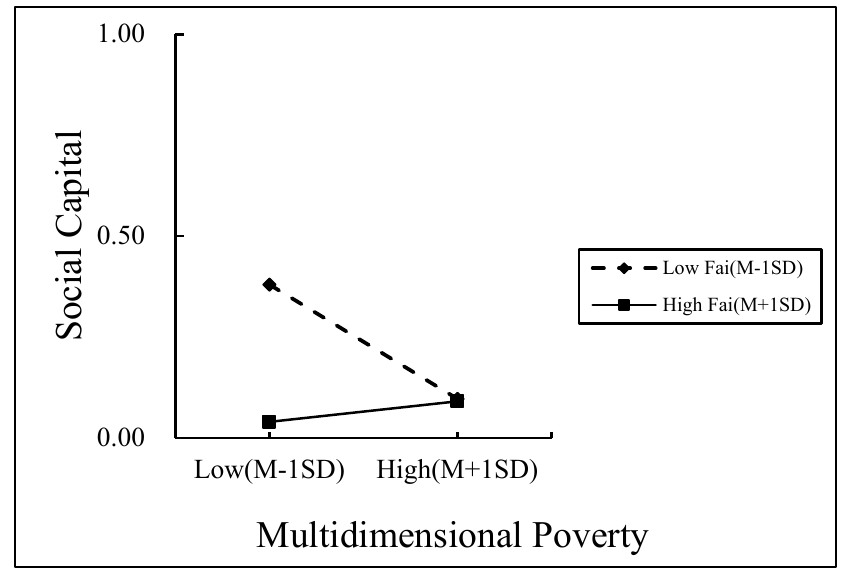
Figure 3. The moderating role of family care in the relationship between multidimensional poverty and social capital.